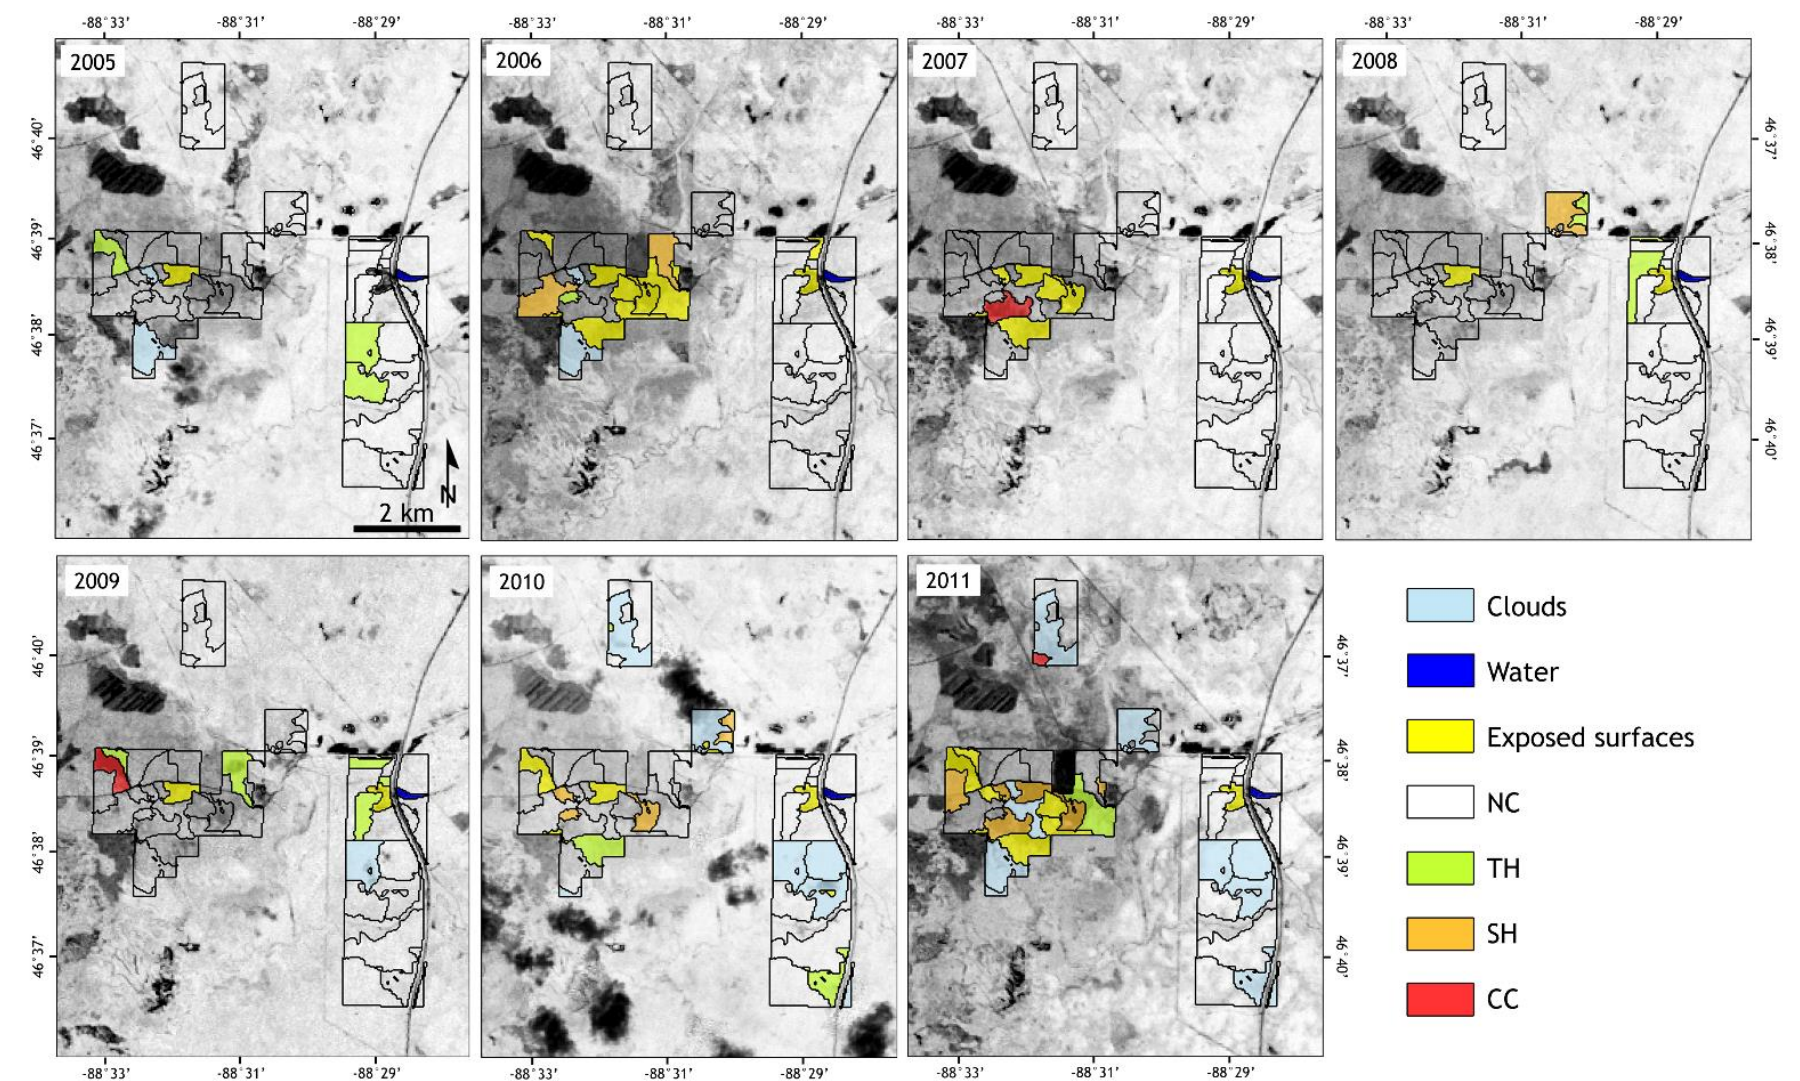
Figure 3. Results of the OBCD classification overlaid onto the 2005–2011 NDVI